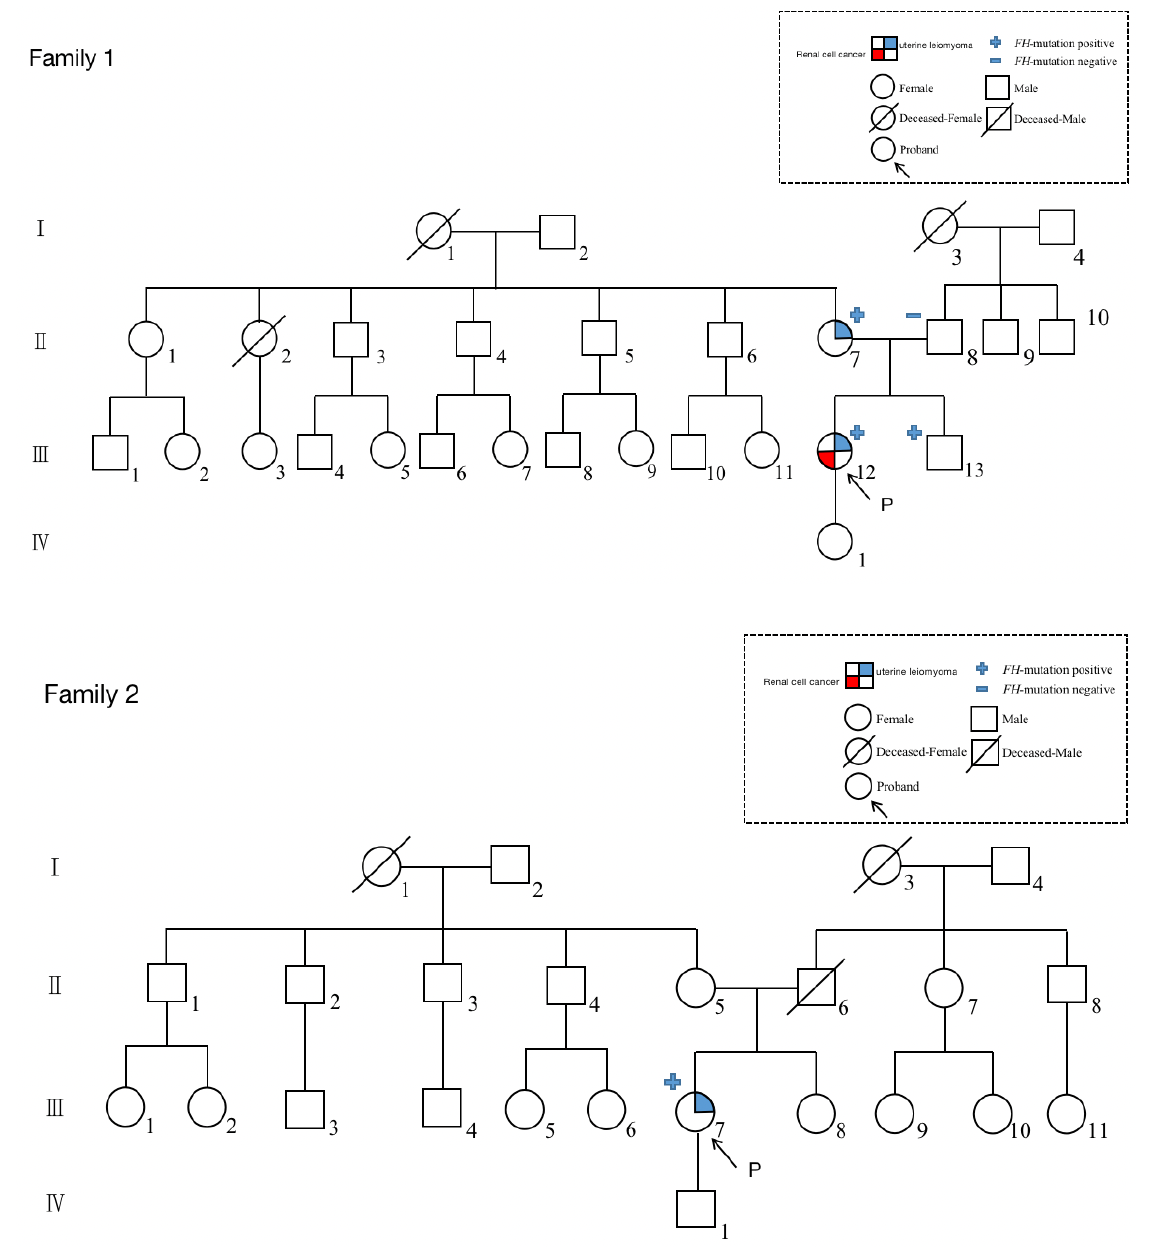
Figure 1. Family